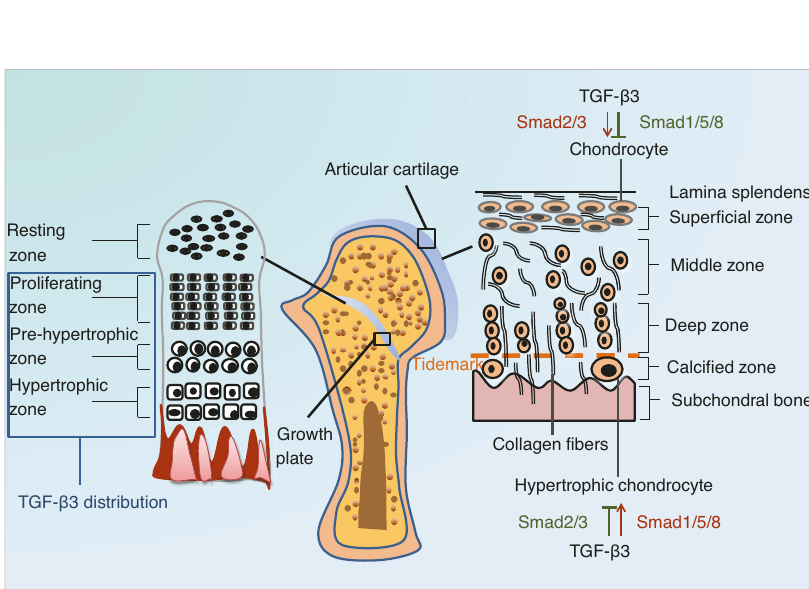
Fig. 4 Schematic diagram showing the basic structure of cartilage and the distribution of transforming growth factor-beta 3 (TGF- β 3). Chondrocytes are divided into articular chondrocytes located in articular cartilage and growth plate chondrocytes residing in growth plate cartilage based on the degree of their terminal differentiation. Growth plate cartilage comprises the resting zone, proliferative zone, pre- hypertrophic zone and hypertrophic zone. TGF- β 3 is mainly expressed in chondrocytes located in the proliferative and hypertrophic zones. Articular cartilage consists of fi ve distinct zones: the lamina splendens, super fi cial zone, middle zone, deep zone and calci fi ed zone. TGF- β 3 is involved in chondrogenic differentiation and chondrocyte hypertrophy through the Smad2/3 pathway and Smad1/5/8 pathway, which play antagonistic roles during different stages of cartilage